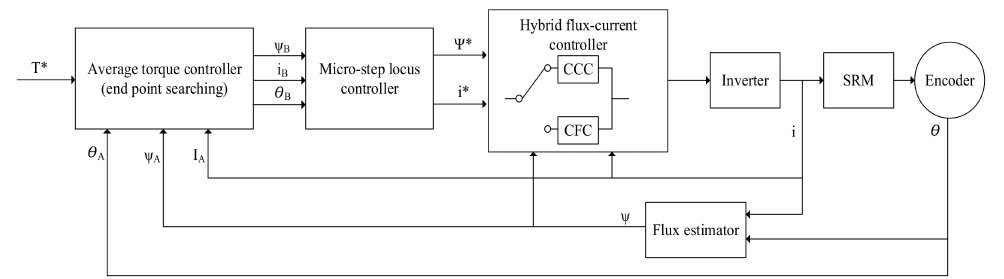
Figure 17. The hybrid flux-current controller diagram for SRM edited from [103].